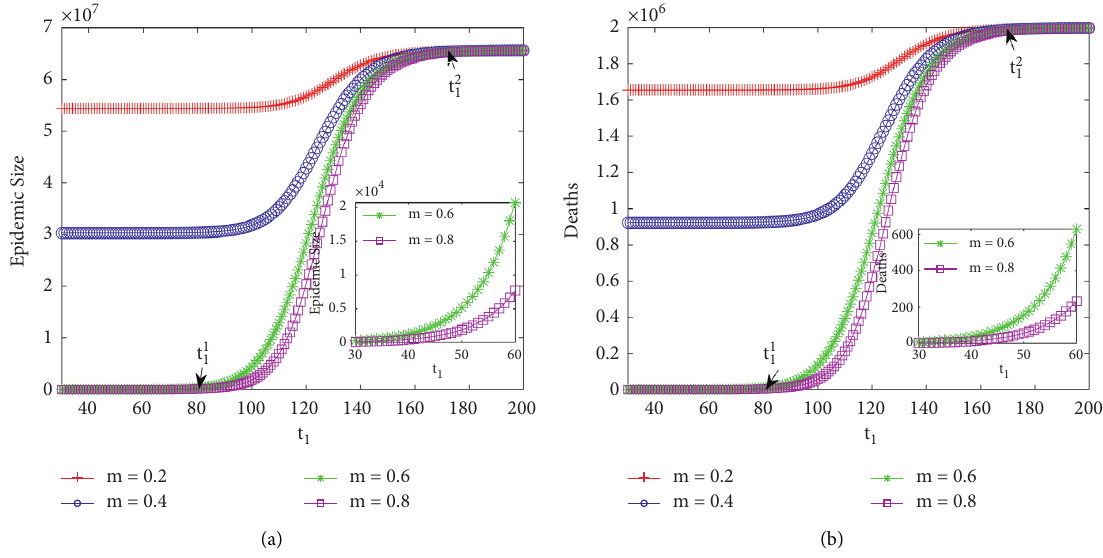
Figure 7: Diagnosis rate ] � 0 . 2. The epidemic size and death number vary with the start time of taking measures. (a) Epidemic size and (b) death